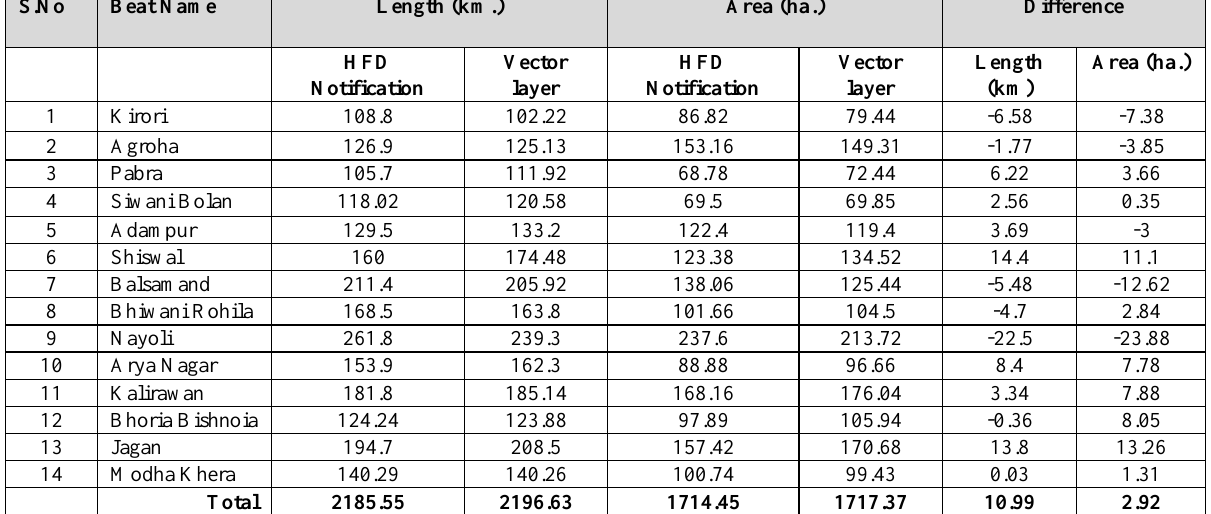
Table. 2. Comparison of Strip vector area with HFD